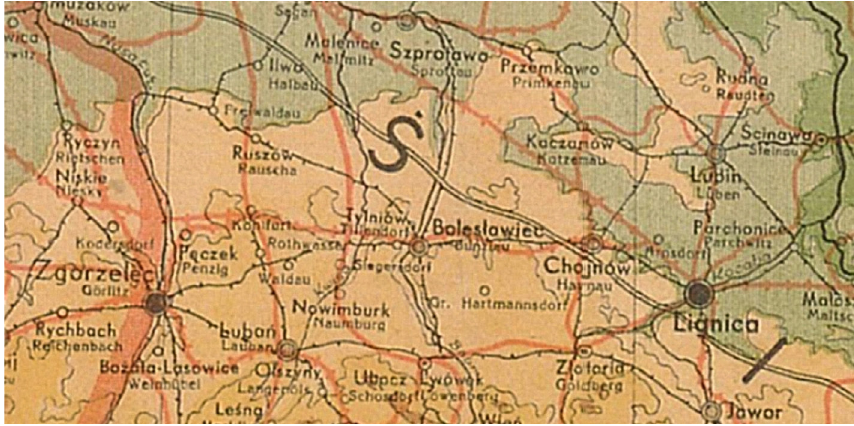
Fig. 6. Part of a map Polskie Ziemie Zachodnie i Pomorze Wschodnie , 1:1,250,000,